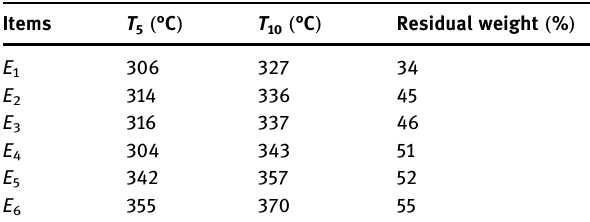
Table 2: TGA data of EP/PAA Items